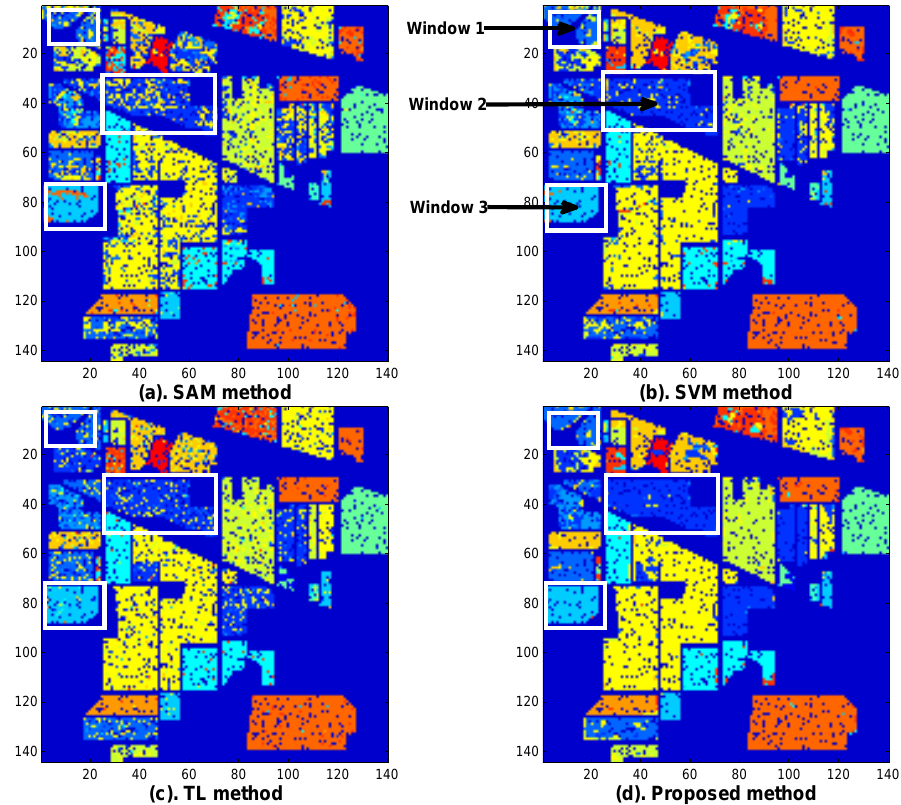
Figure 12. Classification maps of ( a ) SAM method; ( b ) SVM method; ( c ) TL method, and ( d ) proposed method, AVIRIS 92AV3C dataset, 16 classes, 10% training